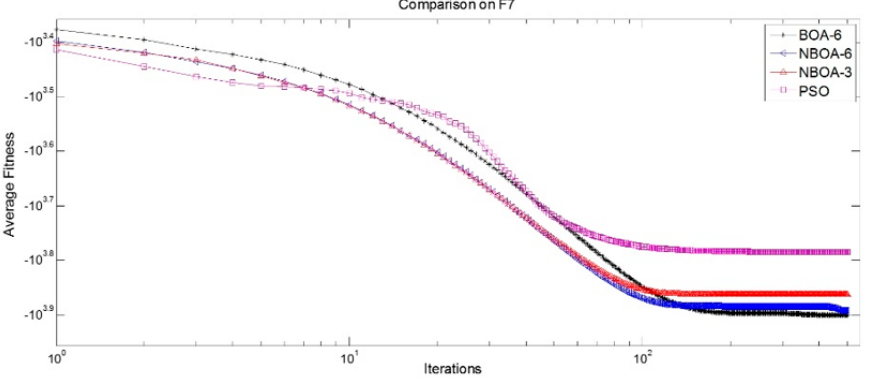
Figure 2. The convergence curves of unimodal functions: The curves of BOA-6 are black, the curves of NBOA-6 are blue, the curves of NBOA-3 are red, and the curves of PSO are purple. All the curves are average convergence curves for 50 computational iterations, and in order to show the curves more clearly, the coordinates were changed by logarithmic processing.